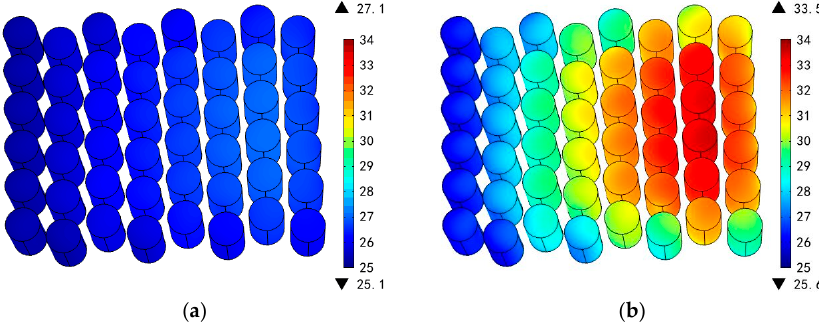
Figure 10. Battery temperature profiles with discharging rates of ( a ) 0.5C and ( b ) 1C at 25 °C. Table 3. Temperature rises and temperature differences at different discharging rates.